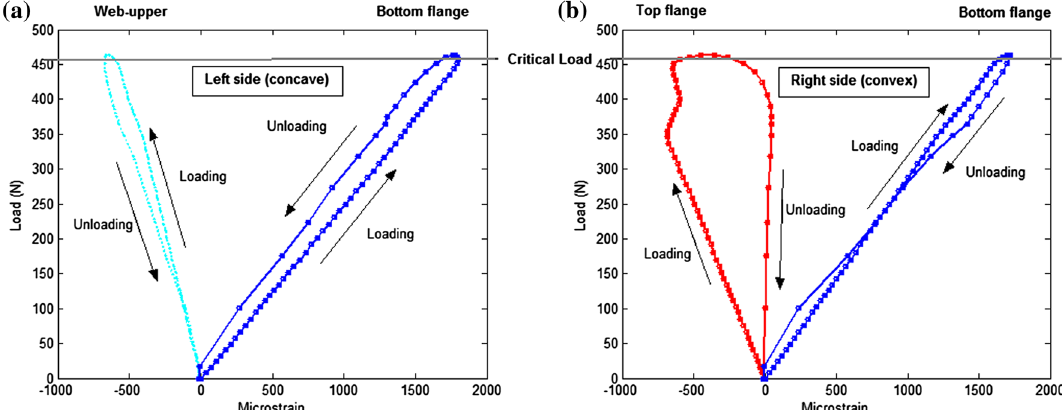
Fig. 15 Variations in the longitudinal strains measured at the a left and b right sides of the ST2 beam at the mid-span.